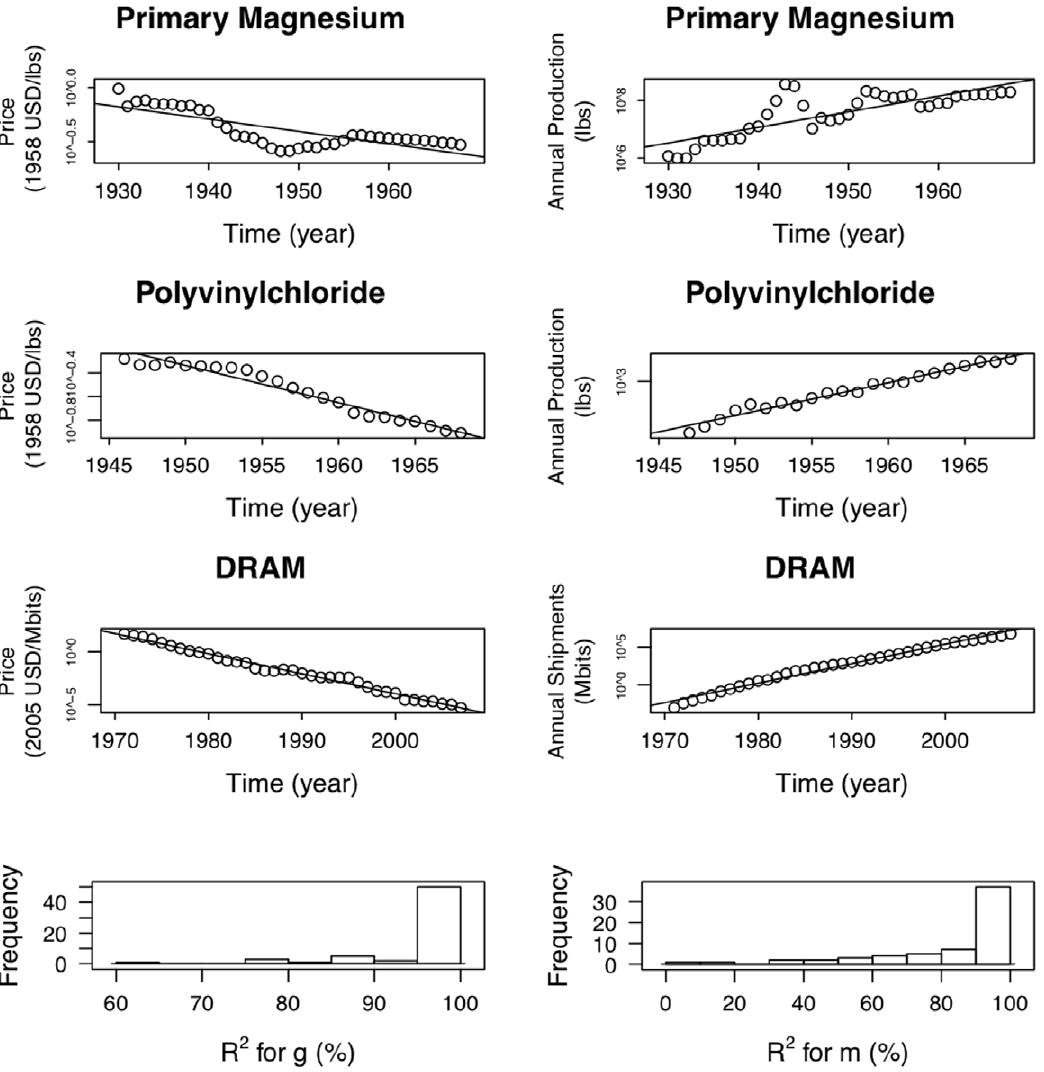
Figure 3. Three examples showing the logarithm of price as a function of time in the left column and the logarithm of production as a function of time in the right column, based on industry-wide data. We have chosen these examples to be representative: The top row contains an example with one of the worst fits, the second row an example with an intermediate goodness of fit, and the third row one of the best examples. The fourth row of the figure shows histograms of R 2 values for fitting g and m for the 62 datasets.